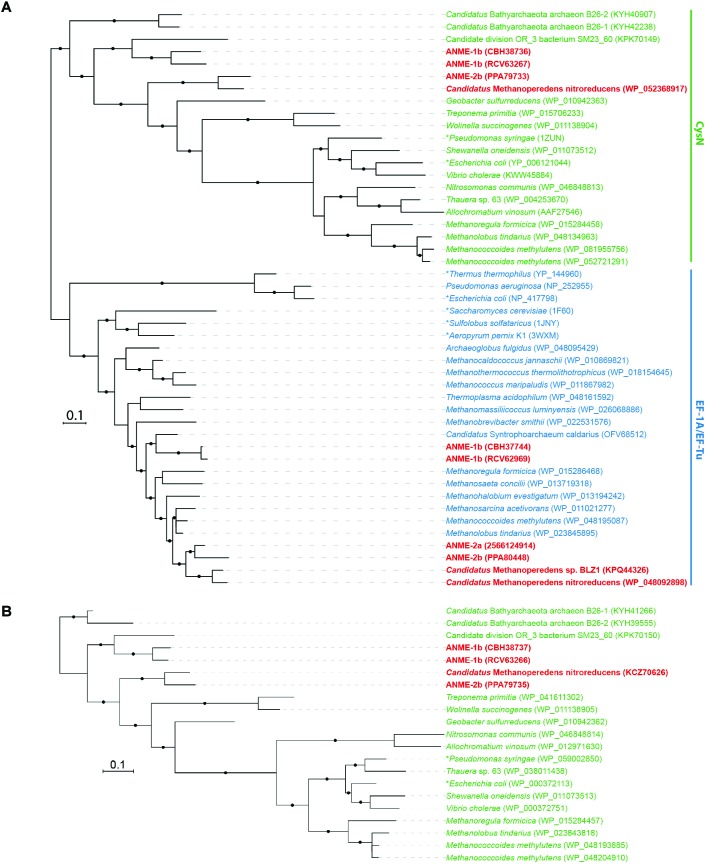
Phylogeny of heterodimeric ATP sulfurylase subunits (CysDN). (A) Bayesian phylogeny of 416 amino acid residues of sulfate adenylyltransferase subunit 1 (CysN) and elongation factor 1 alpha (EF-1A) or elongation factor thermo unstable (EF-Tu) proteins. CysN, in green, formed a separate phylogenetic cluster from the homologous EF-1A and EF-Tu in blue. ANME proteins are bolded in red. The phylogenetic analysis distinguished CysN from their homologous elongation factor in ANME. (B) Bayesian phylogeny of 270 amino acid residues of sulfate adenylyltransferase subunit 2 (CysD) in green. They are found in ANME genomes next to CysN confirming that they are the heterodimeric ATP sulfurylase subunits. Asterisks (∗) indicate proteins that have been studied biochemically or structurally (Liu et al., 1994; Andersen et al., 2000; Vitagliano et al., 2001; Mougous et al., 2006; Schmeing et al., 2009; Kobayashi et al., 2010; Thirup et al., 2015). Protein accession numbers from the NCBI database or gene IDs from the IMG database are shown in parentheses. Black dots on the branches represent Bayesian posterior probability values greater than 90%, and scale bar indicates the number of amino acid substitutions per site.